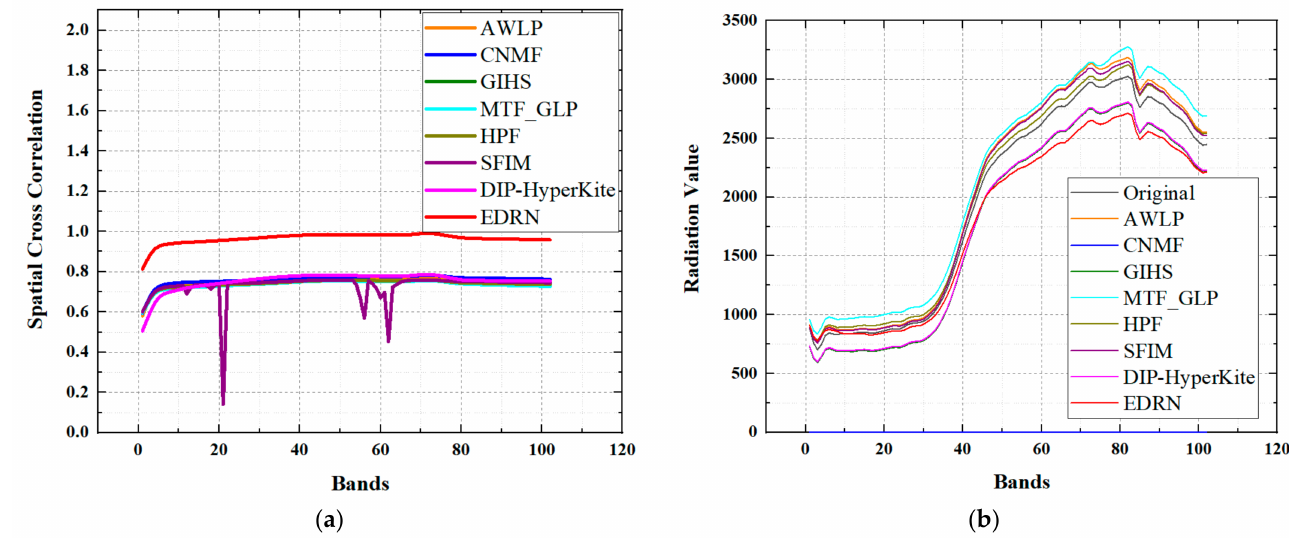
Figure 19. Quality of the compared and proposed fusion methods for the Pavia Center dataset: